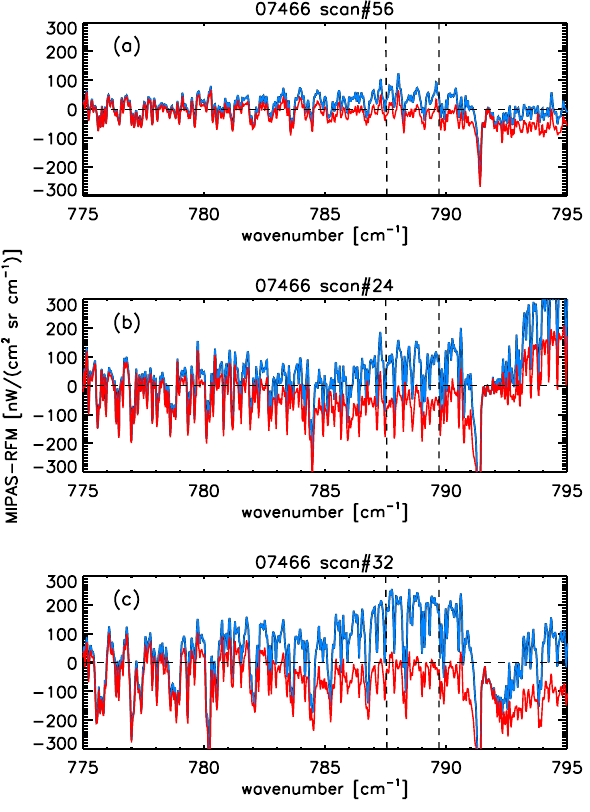
Fig. 4. Examples of MIPAS-E radiance – RFM modelled radiance resiuduals for orbit 07466 on 4 August 2003 at the nominal 12km altitude level. Scenes were chosen which represent the typical be- haviour of (a) low PAN levels below the median vmr for August 2003 of 119ppt (this case has a vmr of 106ppt). Case (b) represents a slightly enhanced retrieved PAN vmr of 164ppt and (c) shows a moderately enhanced case of 379ppt. The blue line is the fit in each case without considering retrieved PAN and the red line is the fit in- cluding retrieved PAN (and continuum). The vertical black dashed lines show the range in which the four PAN microwindows were chosen. The co-ordinates of the MIPAS-E measurements shown are (a) 63 ◦ N, 105 ◦ W, (b) 85 ◦ N, 80 ◦ E and (c) 56 ◦ N, 90 ◦